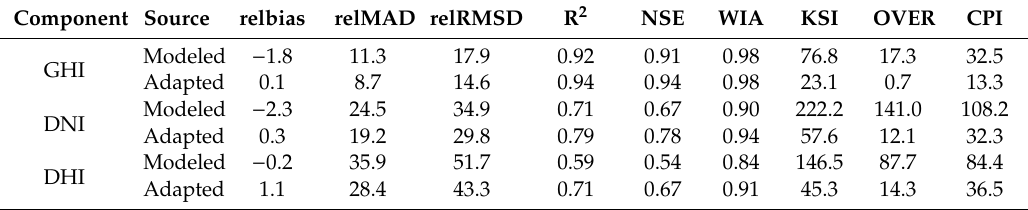
Table 4. Averaged statistical indicators of modeled and adapted time series.